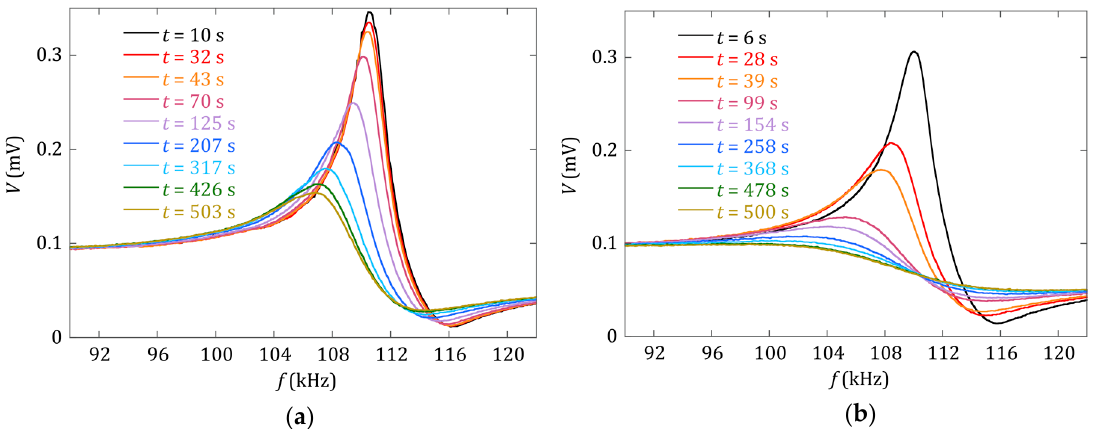
Figure 3. Measured magnetoelastic resonance curves of the sensor at different times during the precipitation process for solutions of oxalic acid and calcium chloride with concentrations of ( a ) 30 mM and ( b ) 100 mM.